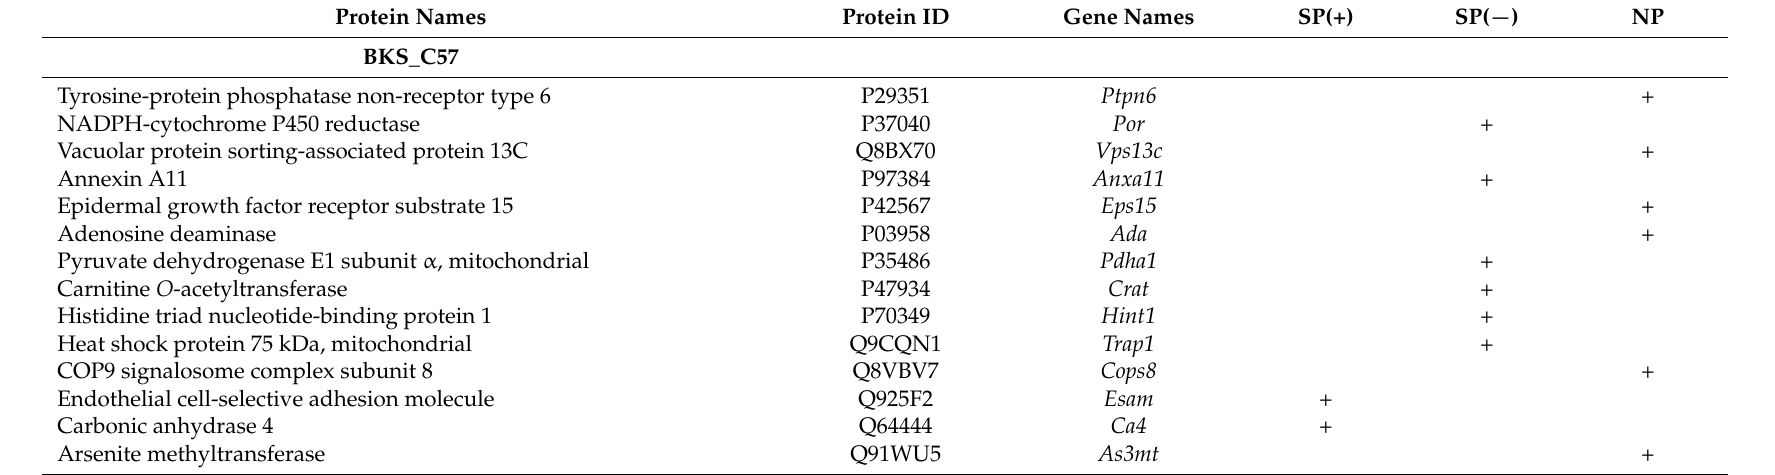
Table 2. Proteins detected in only one genotype in